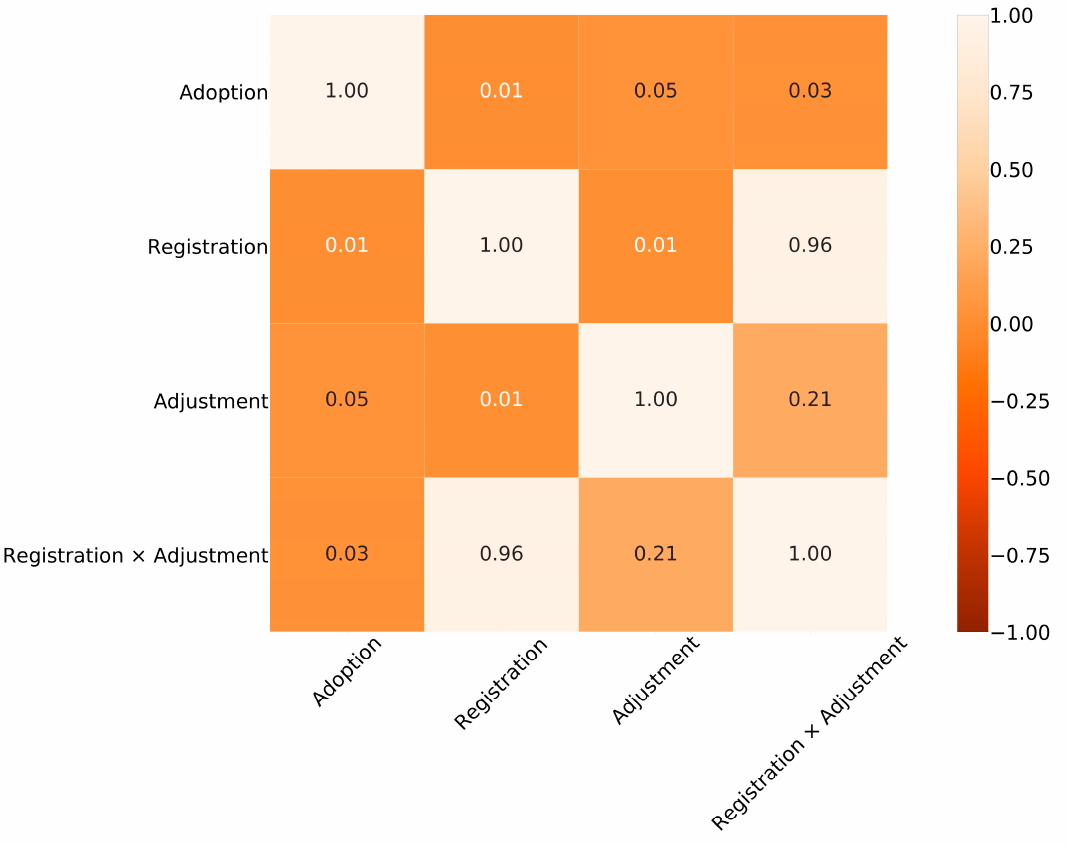
Figure 2. The heatmap of Pearson’s correlation coefficients.